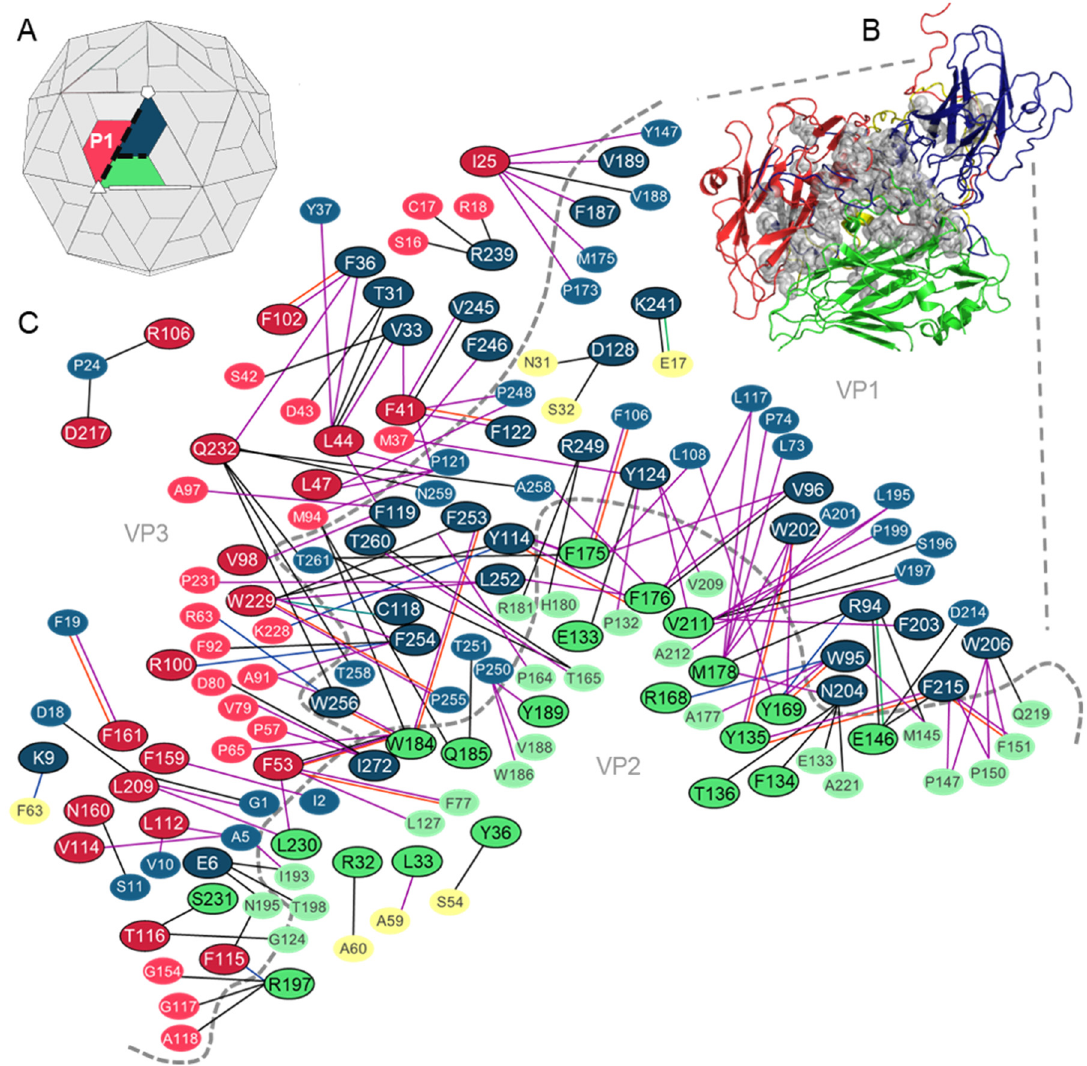
Figure 3. Hotspot residues and their interacting partners at the intraprotomer interfaces of the TMEV capsid. ( A ) Structure of the picornavirus capsid showing a single protomer. The intraprotomer interfaces between the three main capsid proteins are indicated by dashed black lines. ( B ) Structural cartoon mapping of predicted hotspot residues (shown as grey spheres) at the intraprotomer interfaces. ( C ) Schematic network of hotspot residues and the contacts made with their residue binding partners at the intraprotomer interfaces. Hotspot residues are outlined in black. Residues without outlines are non-hotspot partner residues. VP1 residues (blue); VP2 residues (green); VP3 residues (red); VP4 residues (yellow). Noncovalent interactions between hotspots and partners are shown as solid lines: hydrogen bonds (black lines); hydrophobic (purple lines); aromatic (orange lines); aromatic–sulphur (turquoise lines); cation–pi (blue lines); ionic (green lines) interactions.